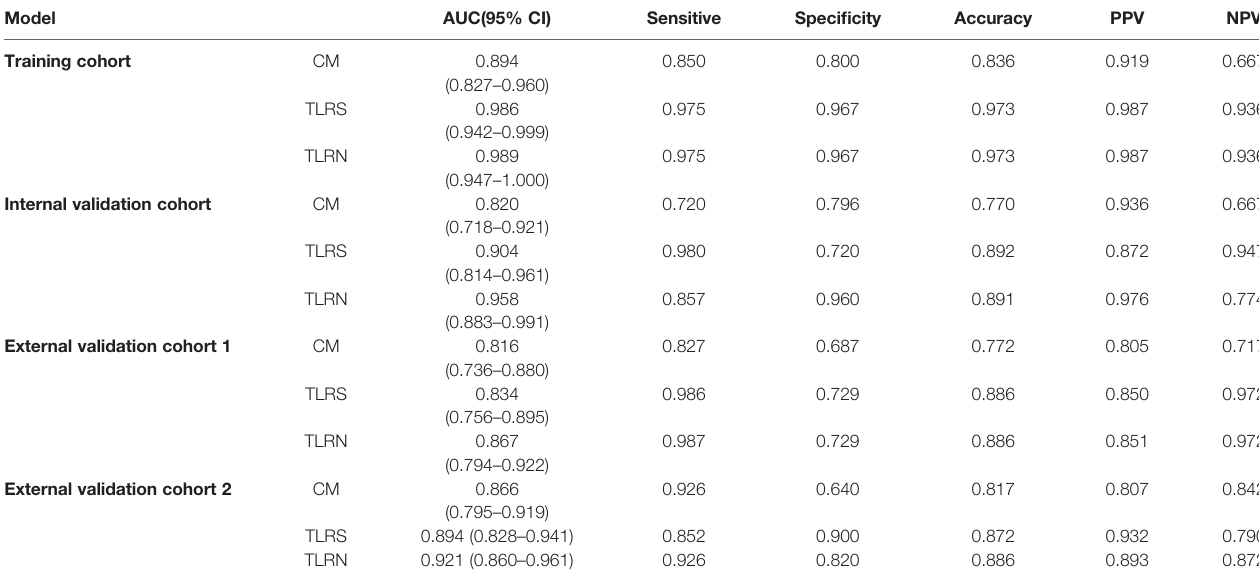
TABLE 2 | Diagnostic performance of the HCR, CM, TLRS, and TLRN in the training and validation sets. Model